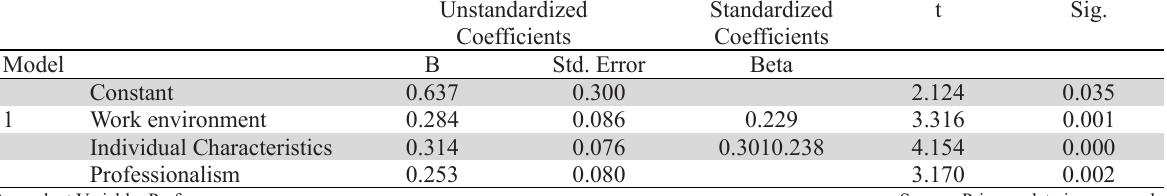
Result of Path Coefficient Test of Work Environment, Individual Characteristics and Professionalism to Performance